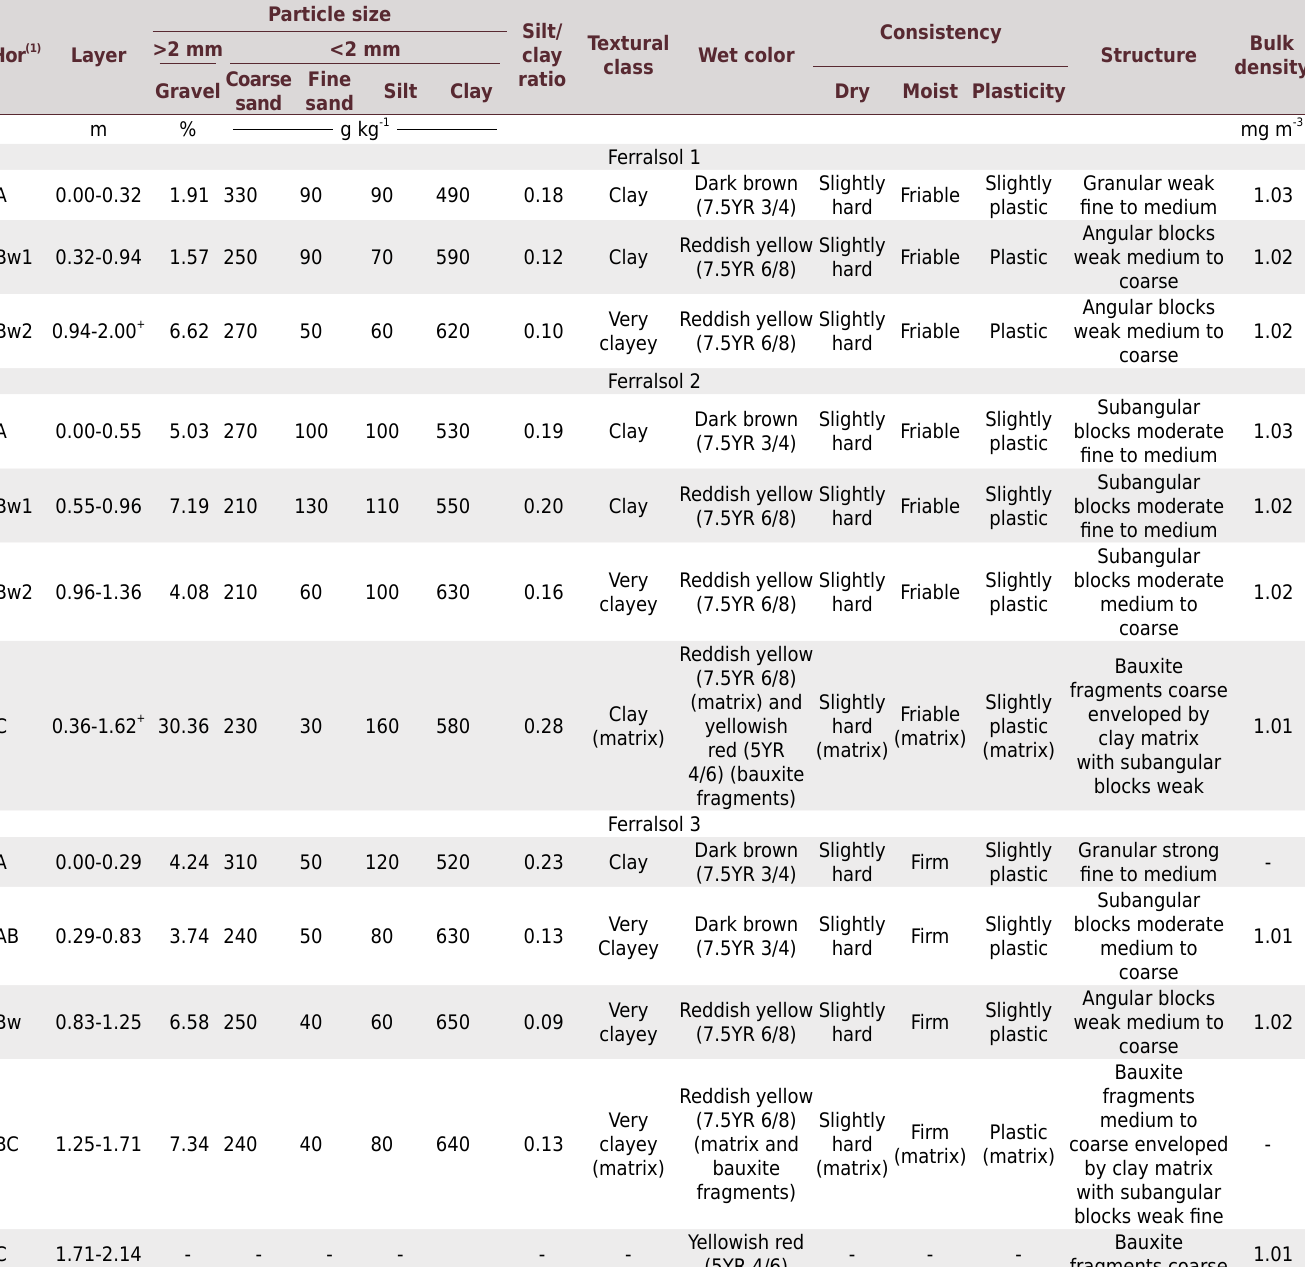
Table 1. Soil morphological and physical properties of the three studied profiles (Ferralsols 1, 2, and 3)